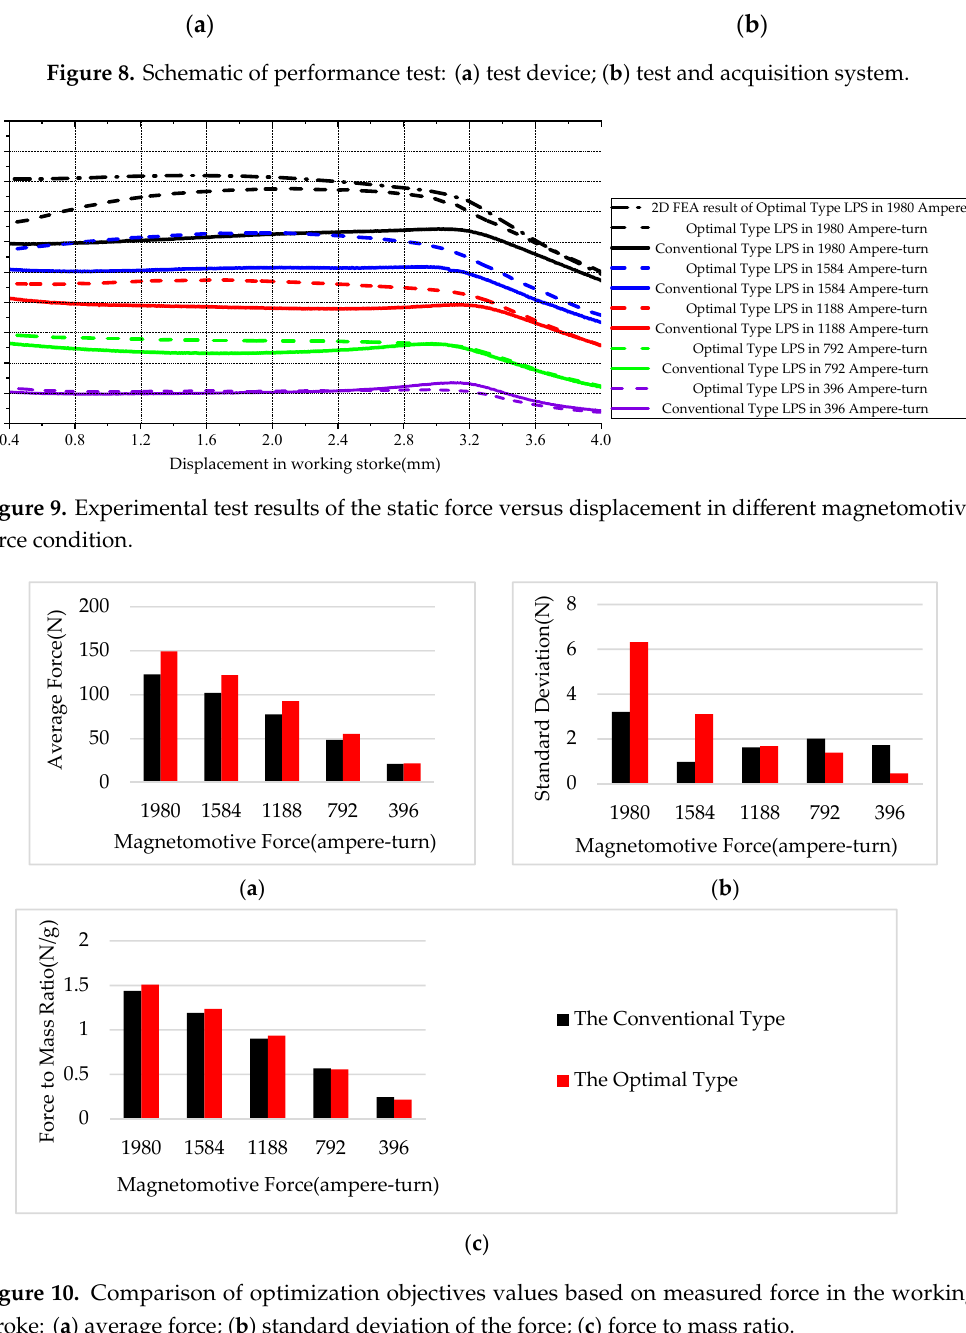
Figure 10. Comparison of optimization objectives values based on measured force in the working stroke: ( a )average force; ( b )standard deviation of the force; ( c )force to mass ratio.